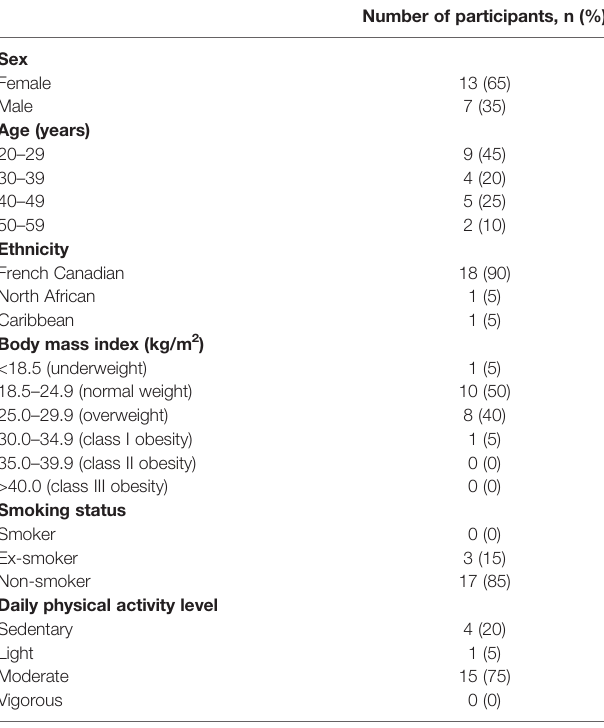
TABLE 1 | Characteristics of the healthy volunteers included in the ELISA quanti fi cation study (n = 20).